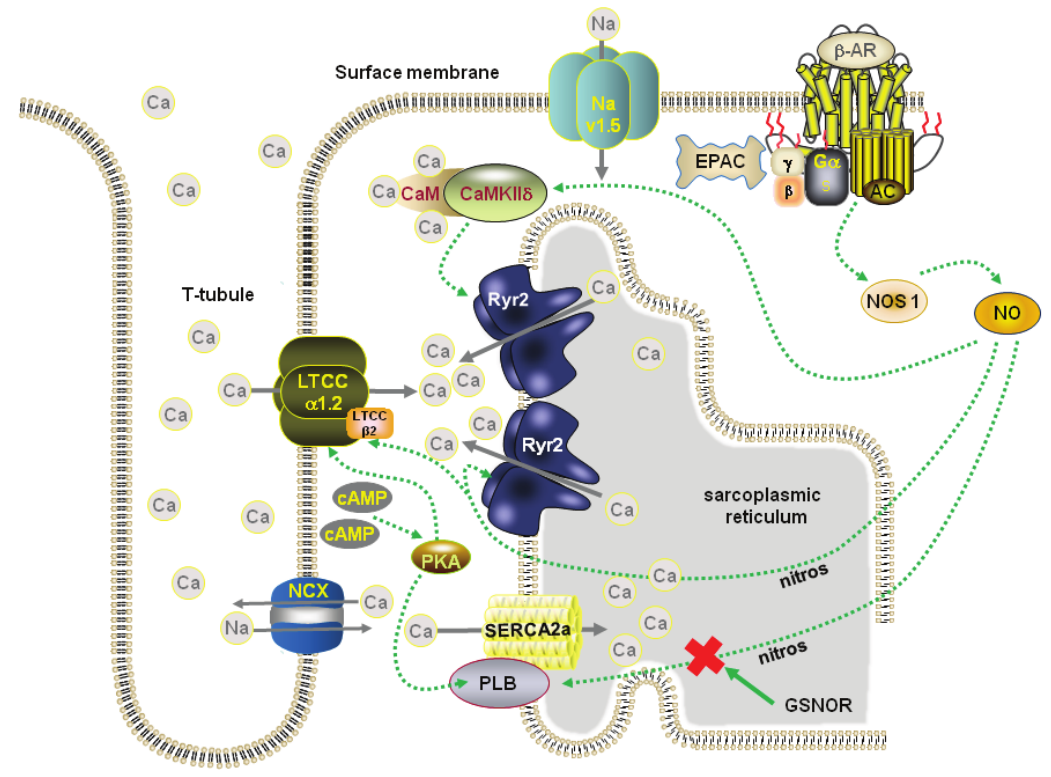
Figure 4. Schematic diagram depicting the activation of nitric oxide synthase 1 (NOS1) following beta-adrenoceptor stimulation. The NO formed can directly activate CaMKII that, in turn, phosphorylates Ryr2 or nitrosylates Ryr2 and PLB. GSNOR (S-nitrosoglutathione reductase) causes